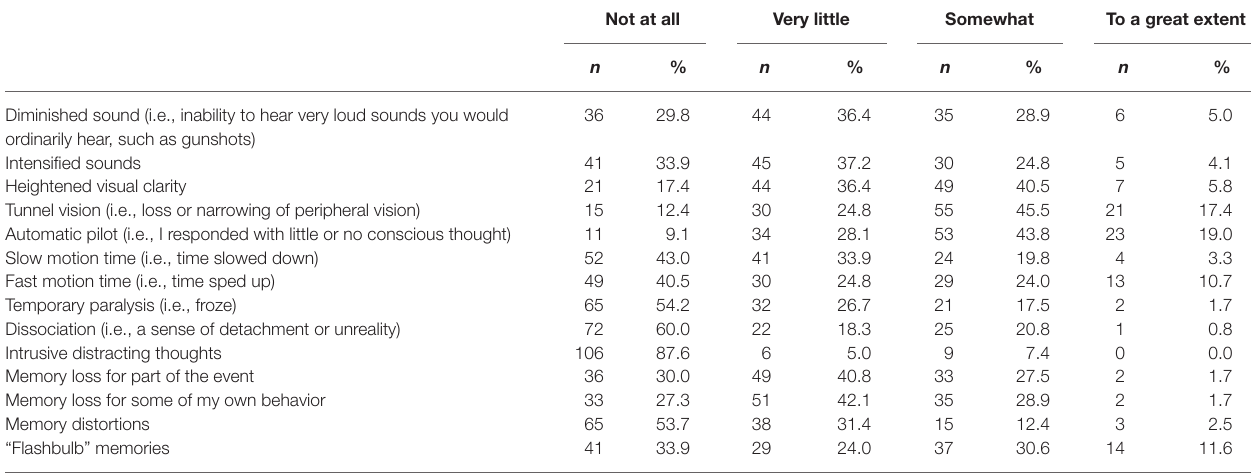
TABLE 4 | Self-reported perceptual and cognitive distortions experienced by participants during- and post-scenario. Not at all Very little Somewhat To a great